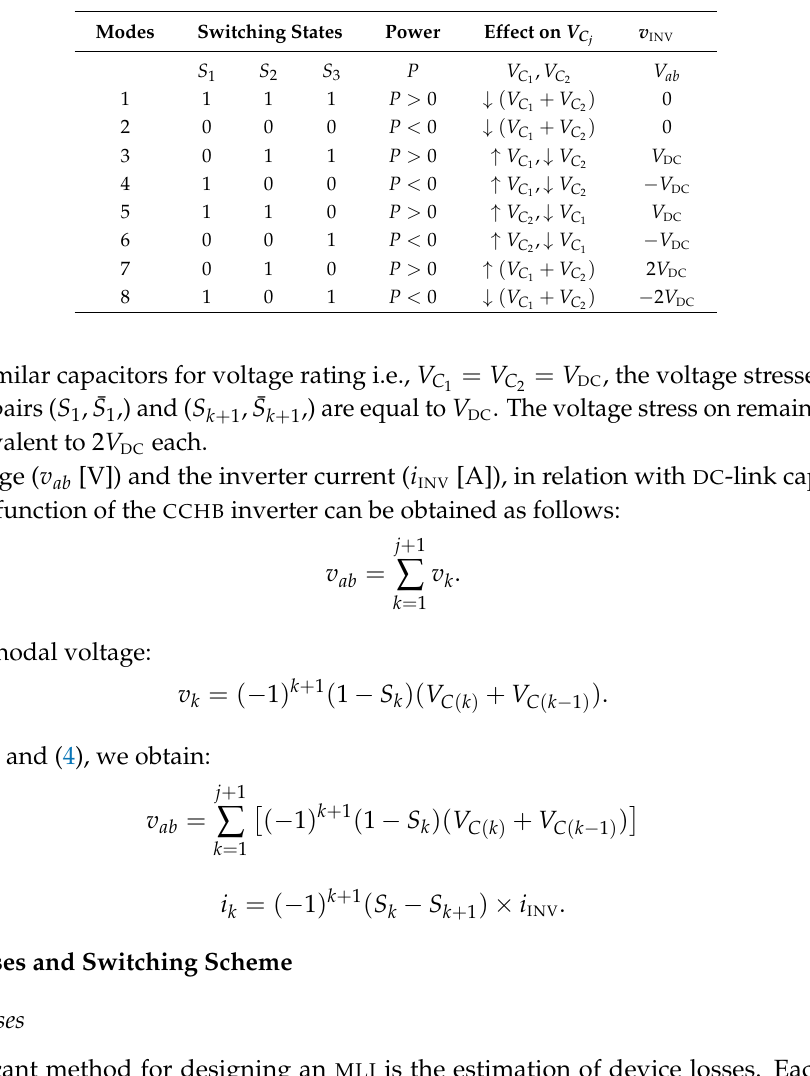
Table 1. Switching states of five-level CCHB - MLI